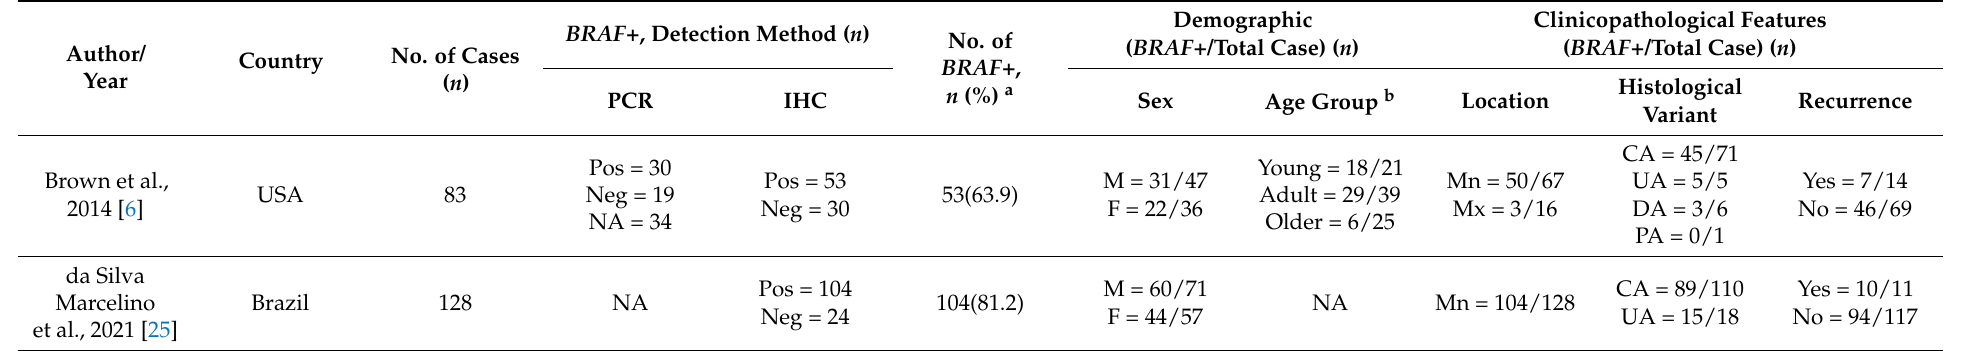
Table 3. The summary of 17 included ameloblastoma studies with BRAF V600E, demographic and clinicopathological features